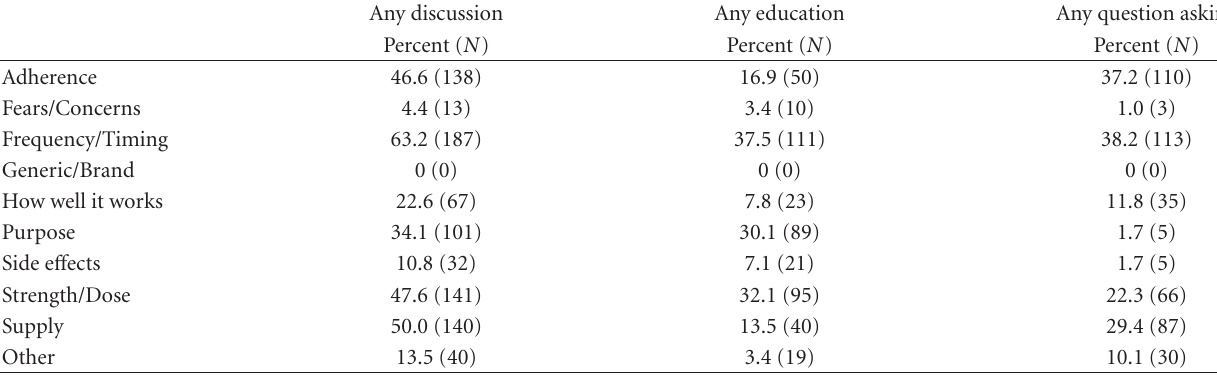
Table 2: Communication about control medications during pediatric asthma visits ( N = 296).